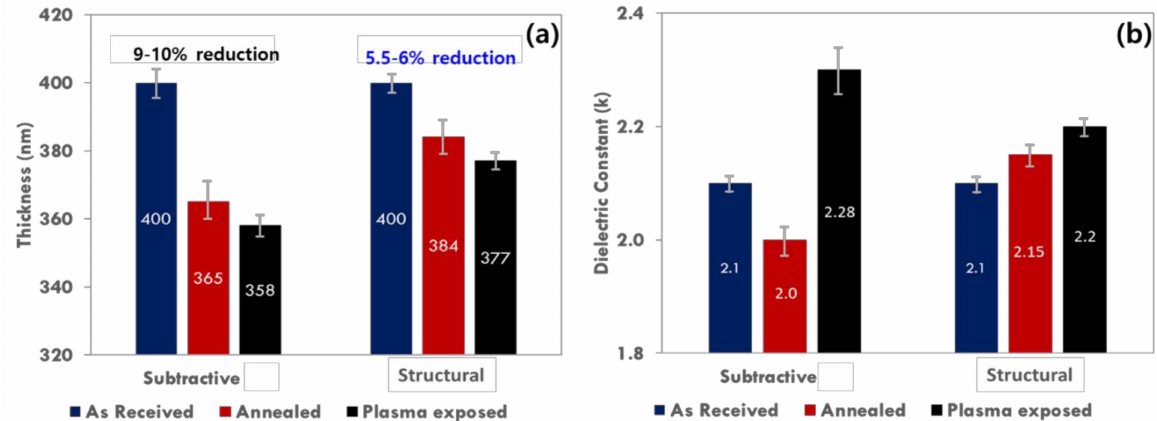
Figure 3. Comparison of the change in dielectric constant and thickness with respect to anneal and plasma exposure between subtractive and structural PLK films. ( a ) Change in deposited film thickness; ( b ) Change in dielectric